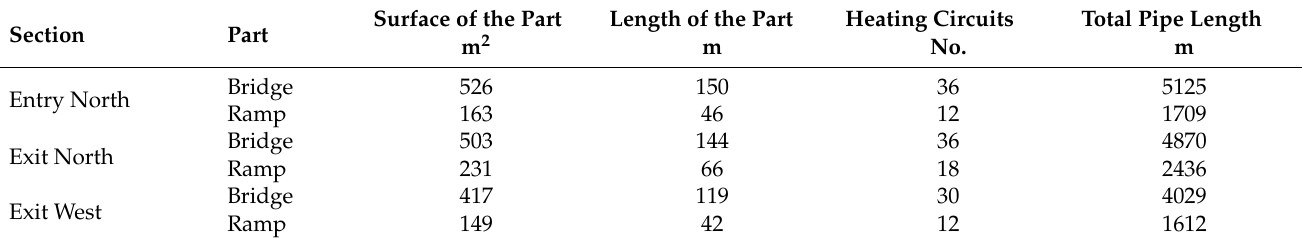
Table 1. Characteristics of the thermally activated bridges and ramps of each HRS section.